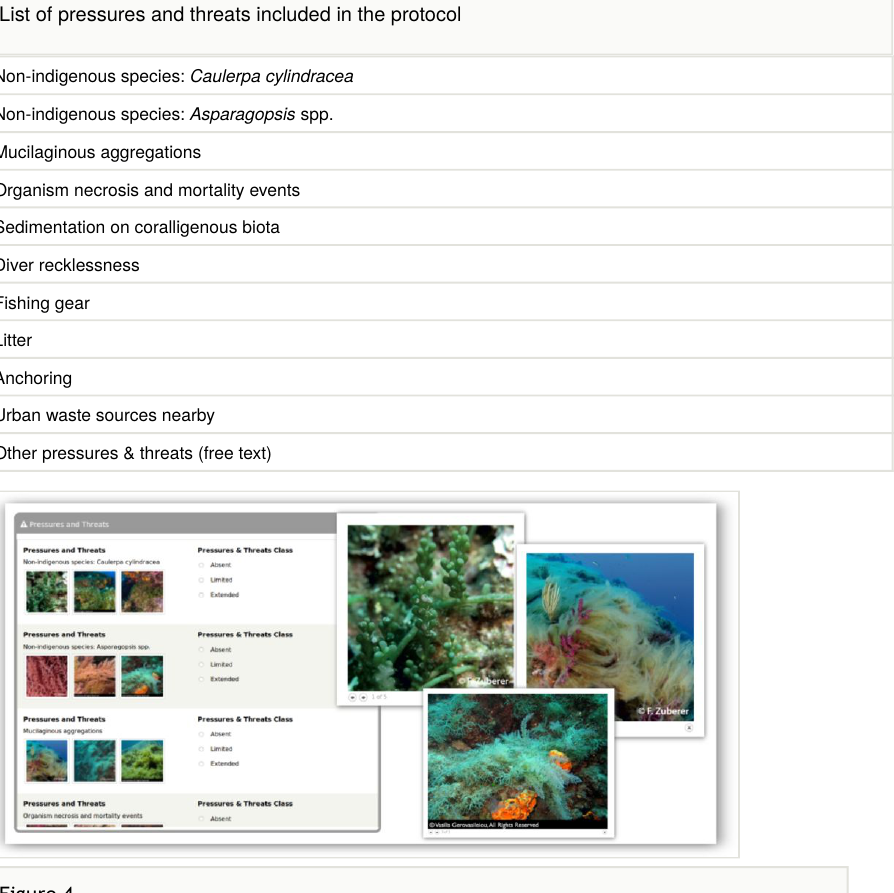
List of pressures and threats included in the protocol